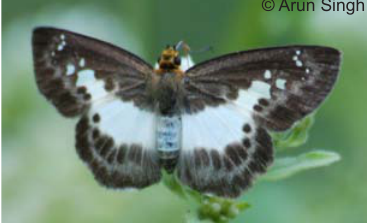
Image 54. Light Straw Ace Pithauria straminiepennis